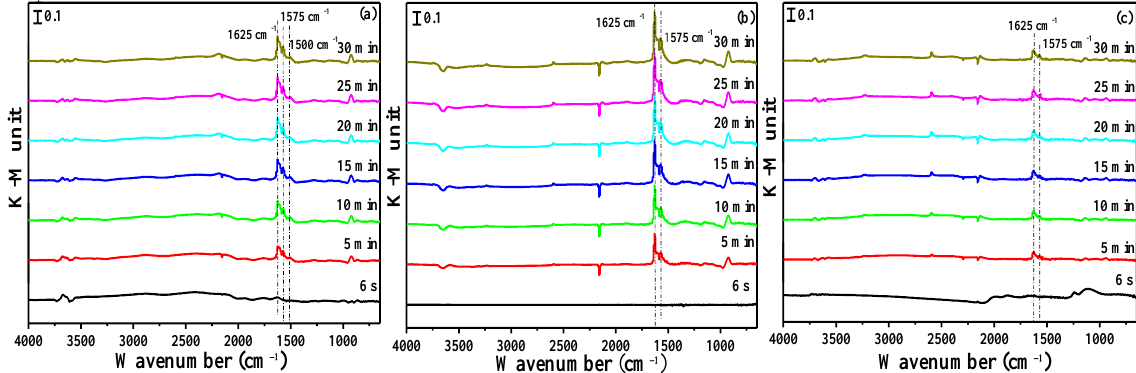
Figure 11. In situ DRIFT spectra of NO + O 2 adsorption on the copper-based zeolites at 150 °C : ( a ) Cu-SSZ-13; ( b ) Cu-ZSM-5 and ( c ) Cu-Beta.